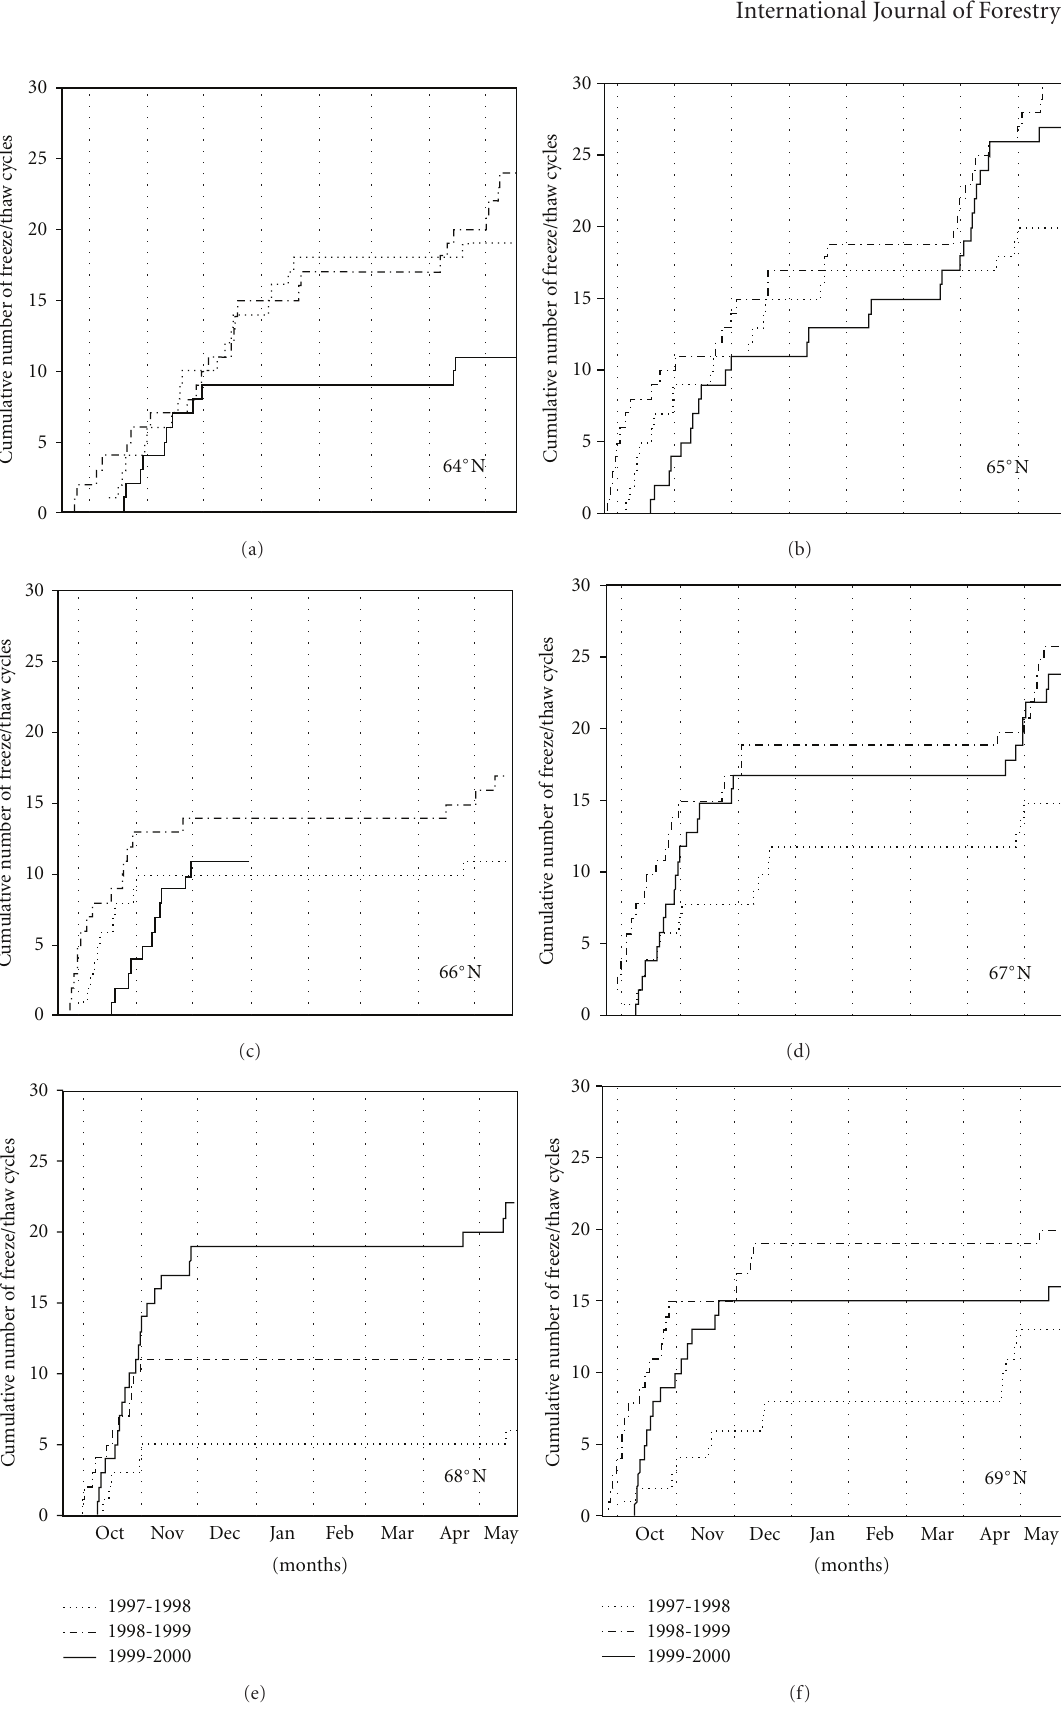
Figure 3: Cumulative number of freeze-thaw cycles at the transplantation sites at the seedling heights during